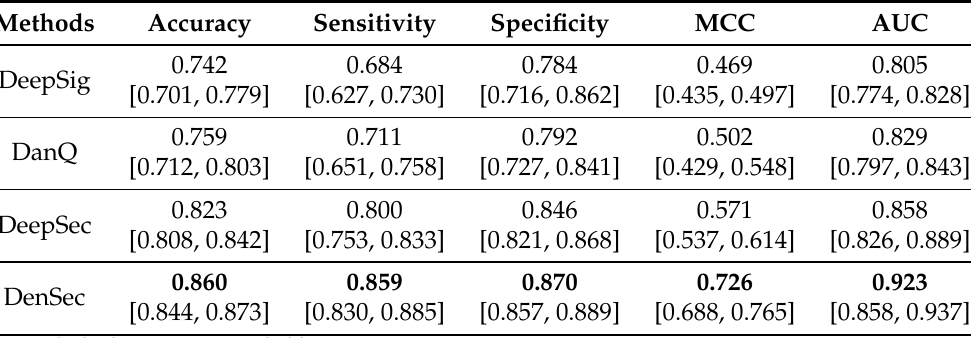
Table 3. The performance evaluation based on the testing dataset, grouped by several deep learning